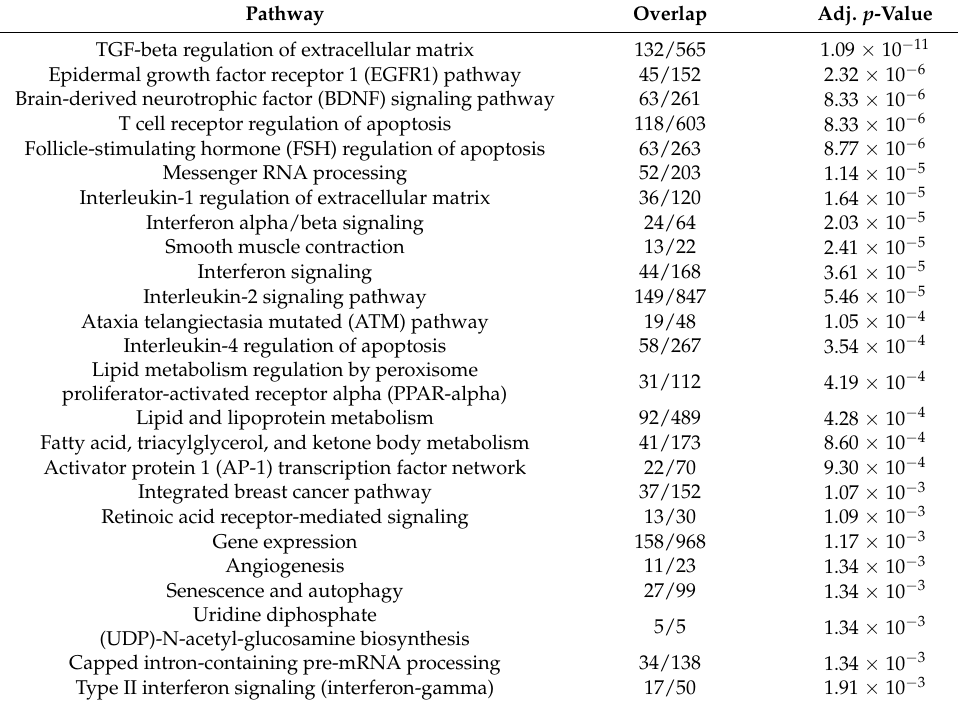
Figure 3. Confirmation of the most highly regulated genes (upregulated ( a ): IFI44L, IFIT1, IFI6, MX1, XAF1; downregulated ( b ): JUN, NPTX1, SLC6A6) in the microarray by qRT-PCR by using custom-designed RT2 PCR arrays from Qiagen. For data normalization, GAPDH and PDGFRB were used as internal controls, the expression of which was shown to be not regulated in the microarray. The experiment was performed one time in triplicates and data represent mean +/ − standard deviation of the mean. Table 3. Pathway enrichment analysis (BioPlanet) of differentially regulated genes (DRGs) between pericytes cultured with and without endothelial cells